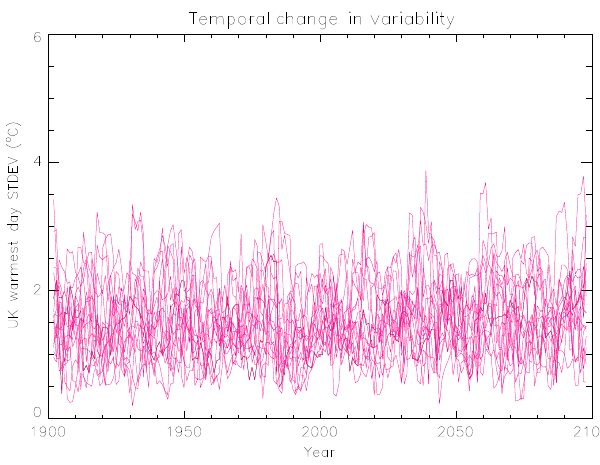
Fig. 5 Timeseries of the standard deviation of the UK mean warmest daytime temperature ( tx01 ) constructed with each of the 16 models. The standard deviation was computed in 5-year rolling windows after subtracting the forced response from model simulations with all